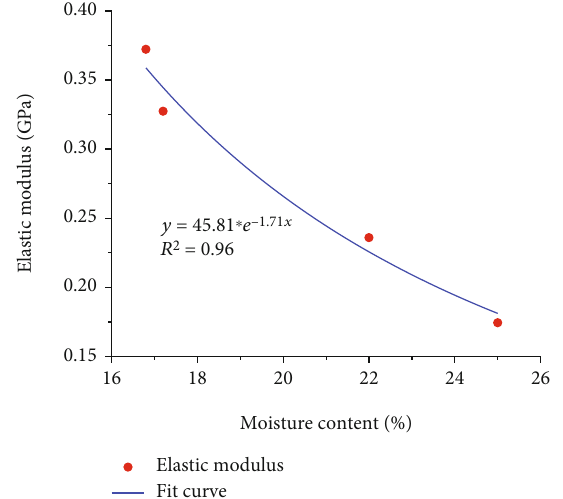
Figure 5: In fl uence curve of moisture content on elastic modulus of the coal